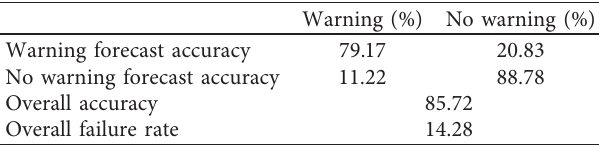
Figure 7: Default distance, default probability, and safe size prediction under different debt scales. Table 2: Accuracy results of government debt risk